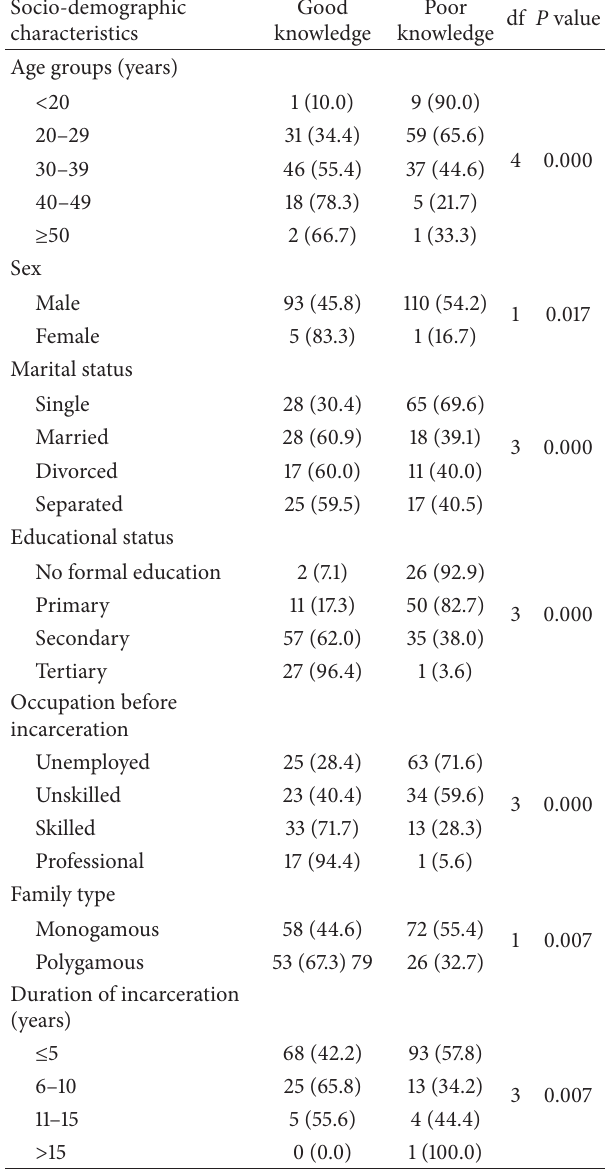
Table 6: Relating sociodemographic characteristics of respondents with knowledge about reproductive health